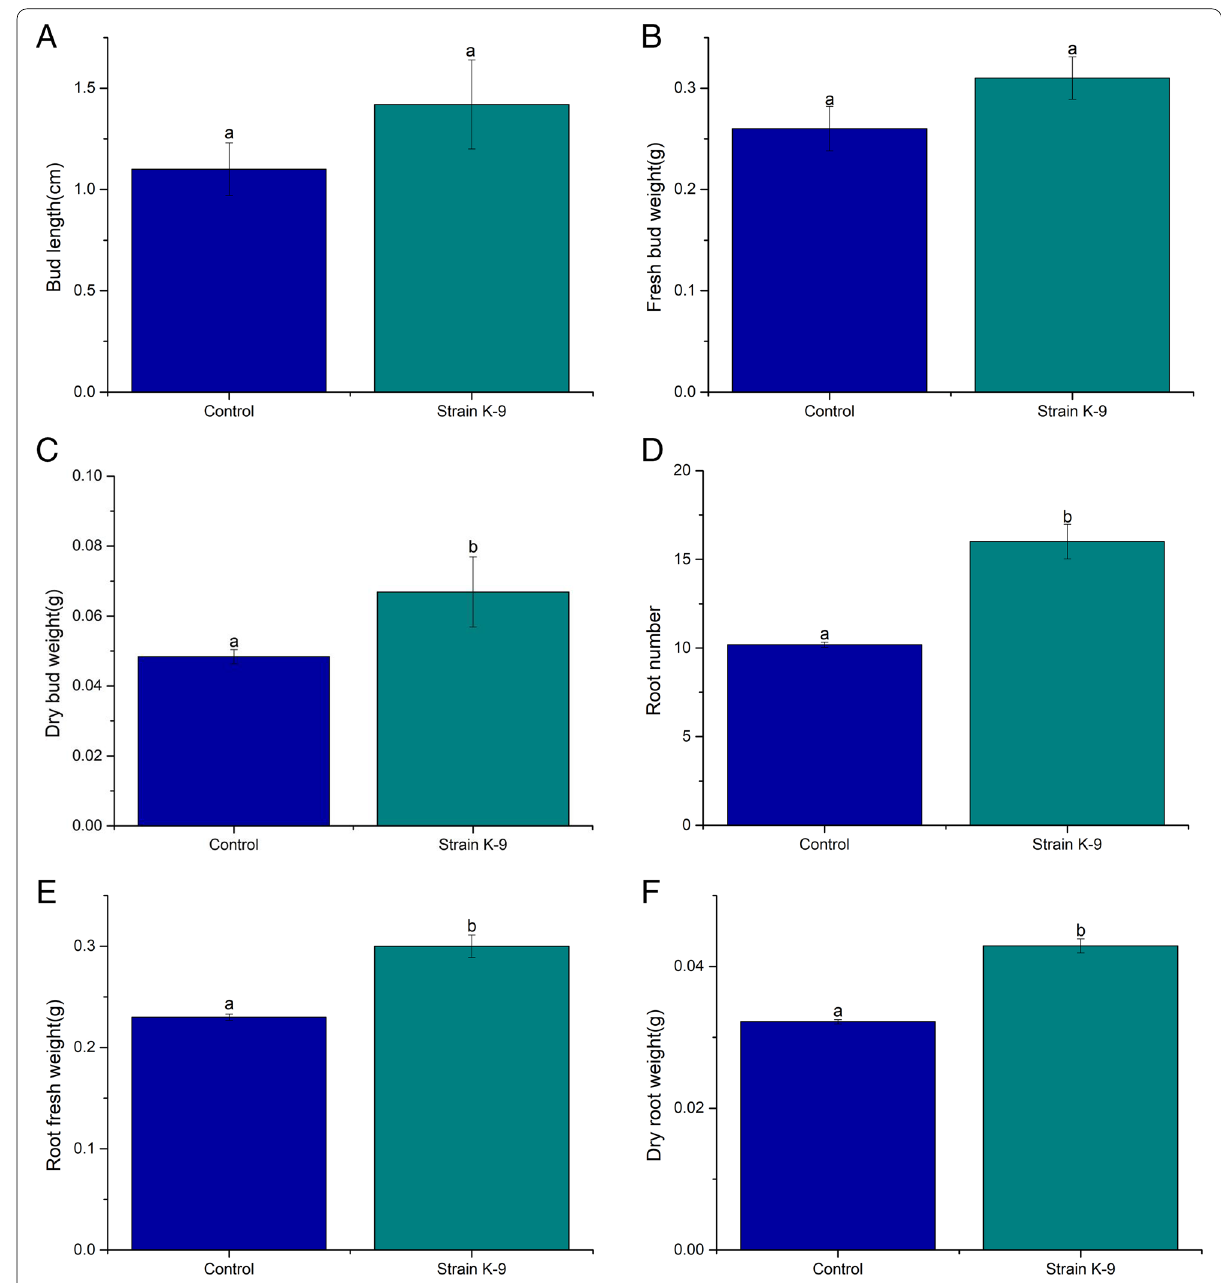
Fig. 5 Effect of strain K-9 on potted potato germination in greenhouse. Each treatment had 3 replications. Different letters indicate significant differences according to the Duncan’s multiple range test ( P < 0.05). A Bud length. B Fresh bud weigh. C Dry bud weight. D Root number. E Root fresh weight. F Dry root